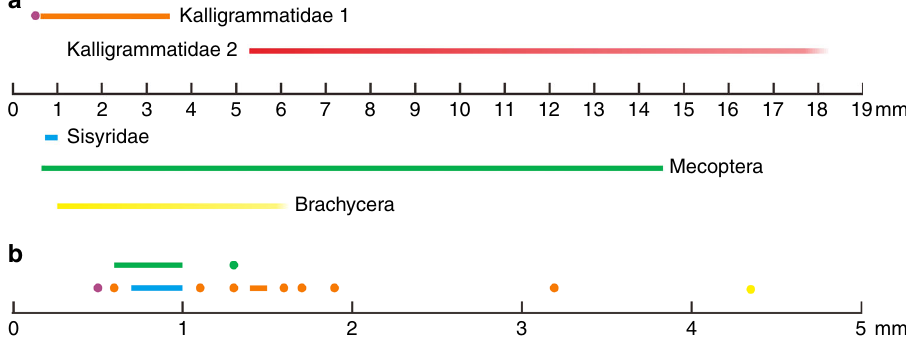
Fig. 4 Proboscid length of Mesozoic long-proboscid insects. a All known Mesozoic long-proboscid insects. The purple dot represents Fiaponeura . The orange bar (Kalligrammatidae 1) represents the range of proboscid lengths of late Cretaceous kalligrammatids from Burmese amber. The red bar (Kalligrammatidae 2) represents the range of proboscid lengths of Jurassic and Early Cretaceous kalligrammatids from rocks. The blue bar (Sisyridae) represents the range of proboscid lengths of Cretaceous spongilla fl ies. The green bar (Mecoptera) represents the range of proboscid length of Jurassic and Cretaceous long-proboscid scorpion fl ies. The yellow bar (Brachycera) shows the range of proboscid lengths of Jurassic and Cretaceous long-proboscid brachyceran fl ies. b Long-proboscid insects in late Cretaceous Burmese amber. The purple dot represents Fiaponeura . Orange and yellow dots represent kalligrammatids and fl ies, respectively, and blue and green bars represent spongilla fl ies and scorpion fl ies, respectively. See Supplementary Tables 1 and 2 for